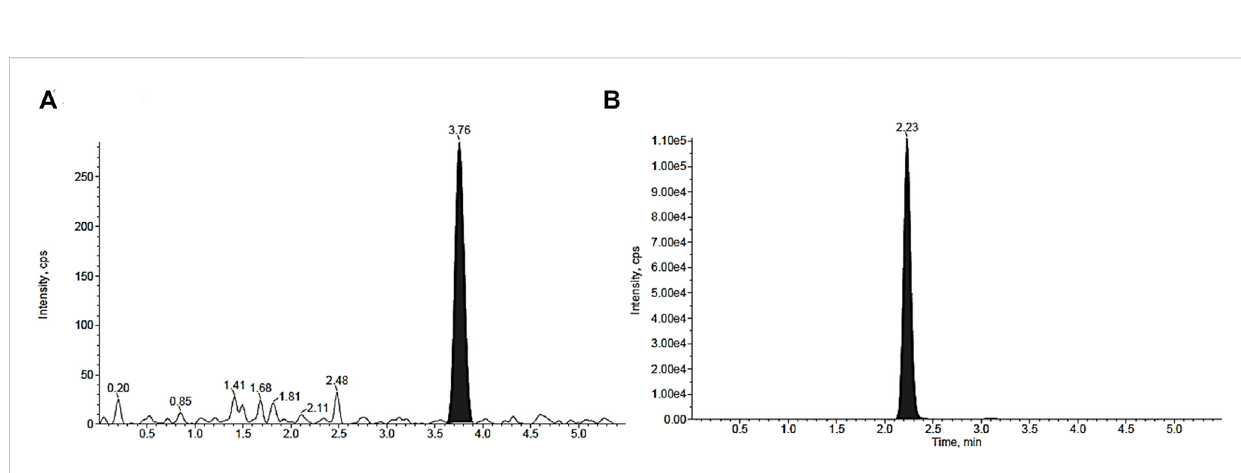
factor of 1/X 2 (X = concentration), a method that covers all clinical concentrations of 2HF. A correlation coef fi cient of 0.9969 was recorded during the validation study (Figure 5).